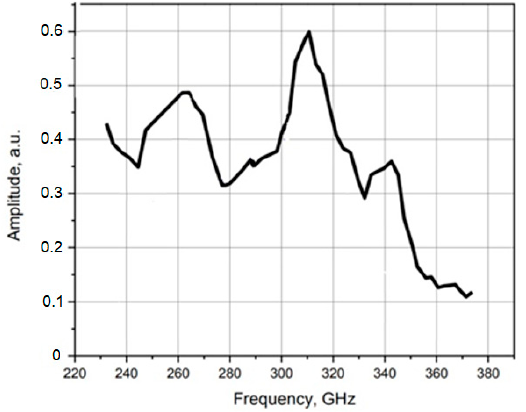
Figure 9. Experimental frequency response of the CEB-array [14].